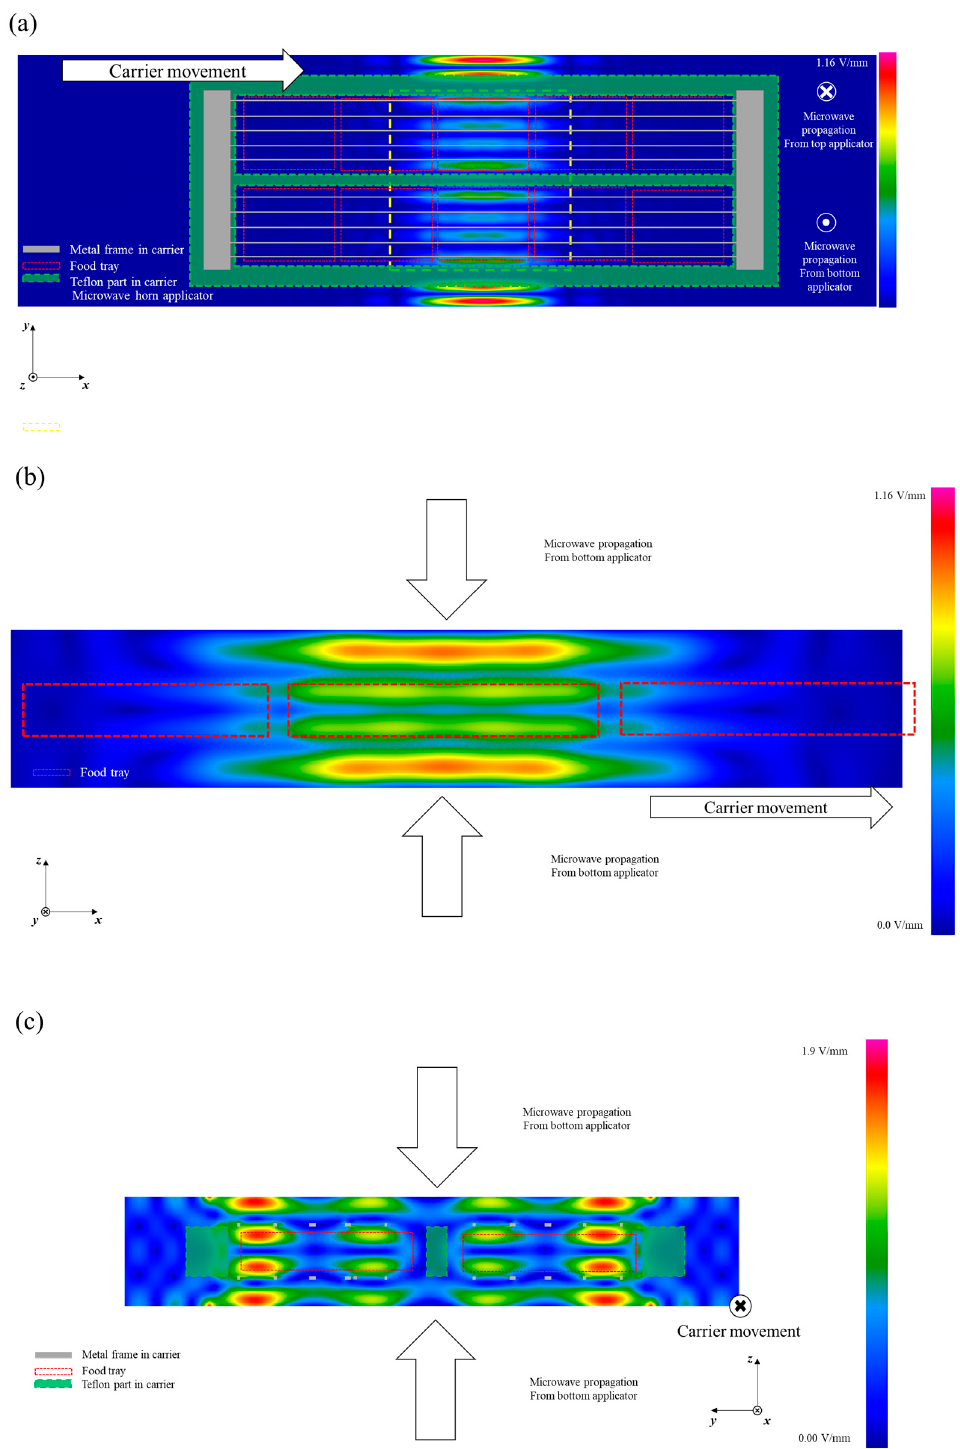
Figure 3. Time average electric field in the cavity of the MATS system with a food transport carrier. ( a ) x–y plane, ( b ) x–z plane, and ( c ) y–z plane (scales are adjusted for better electric field visualization).